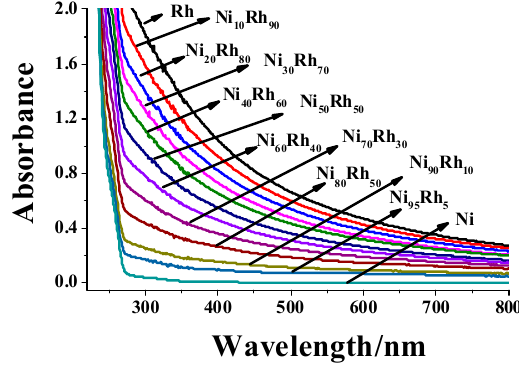
Figure 1. Ultraviolet-visible spectrophotometry (UV-Vis) spectra of colloidal dispersions of Rh (100–x) Ni x nanoparticles (NPs) (x = 0, 10, 20, 30, 60, 80, 90 and 100) ( R ISO = 40, R ISO presents the molar ratio of ISOBAM-104 in alkaline solution to the total metals in the colloidal catalyst mixture; C Metal = 0.66 mM, reduced under ice-water bath for 1 h.).